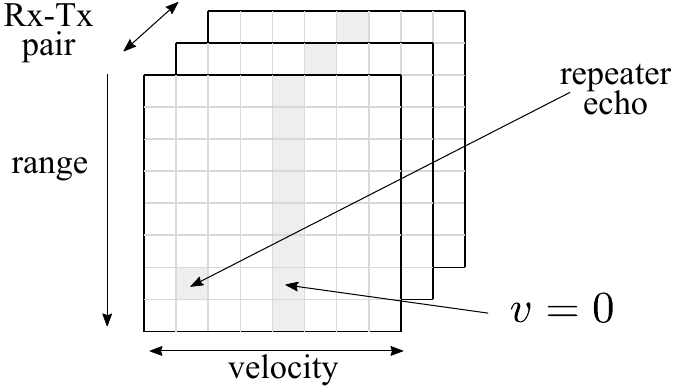
Figure 13. Extraction of crossambiguity bins before scene image calculation.